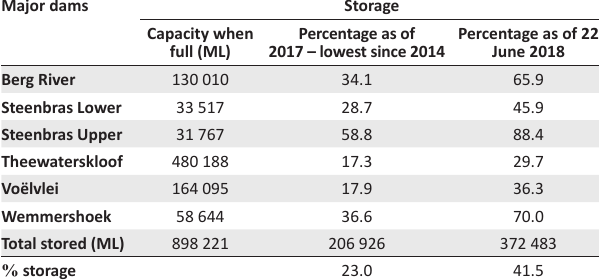
TABLE 2: Dam water levels for six largest dams supplying water to Cape Town. Major dams